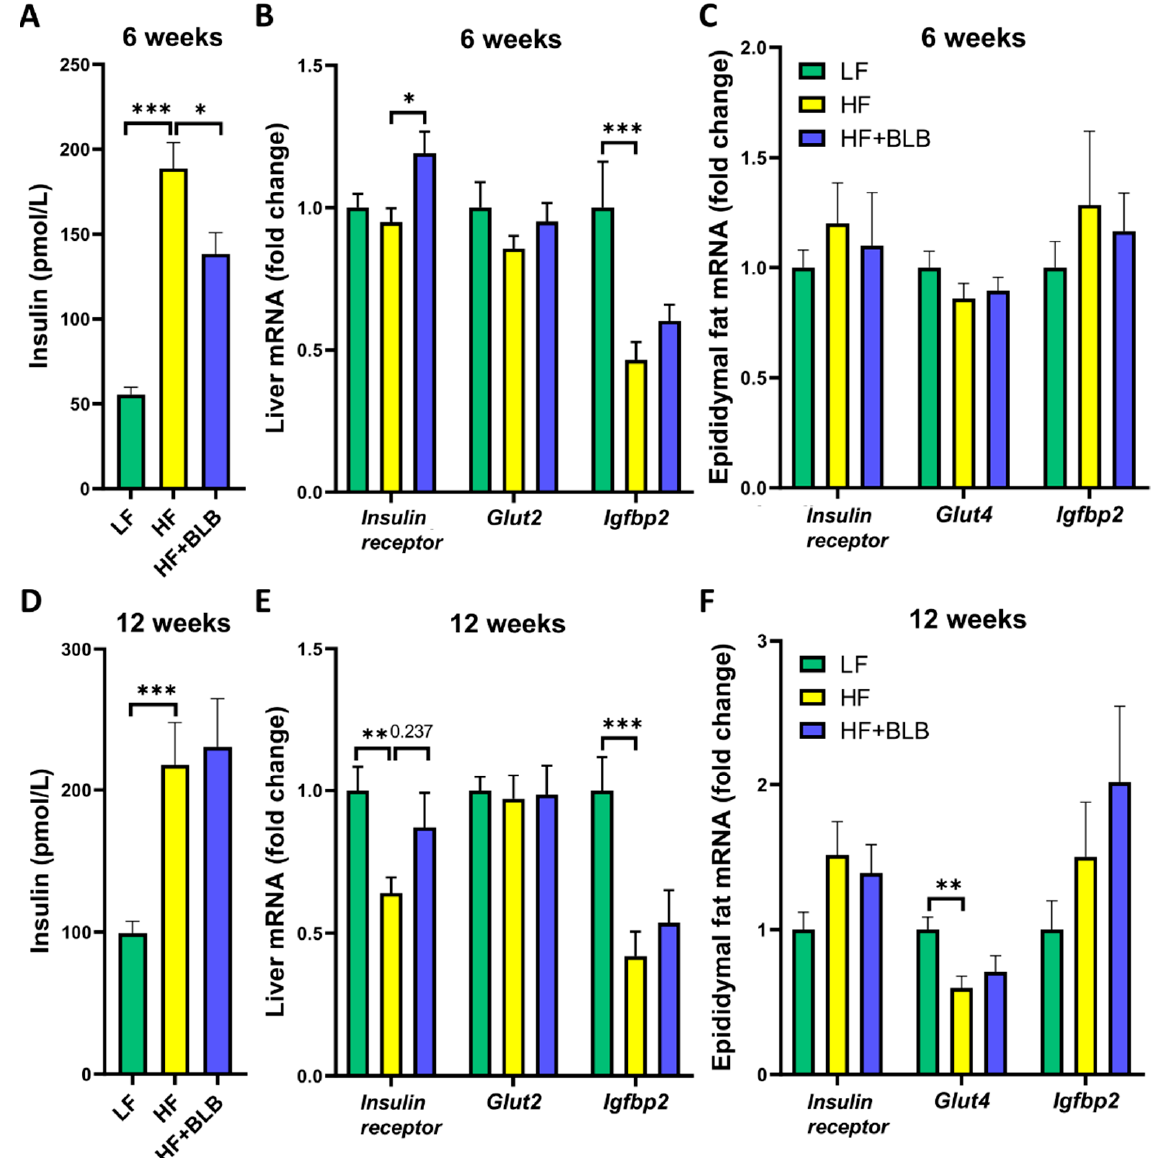
Figure 5. Insulin concentration, insulin receptor, glucose transporter, and insulin-like growth factor binding protein expression. The mice received a low-fat diet (LF, 10% of energy from fat), a high-fat